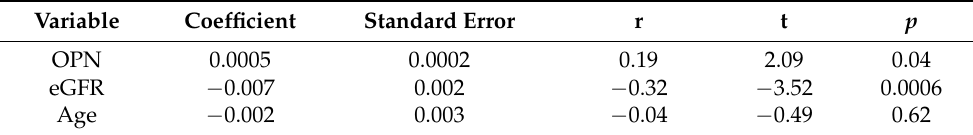
Table 4. Variables associated with PAH. In the table, we show a multiple regression model of predic-